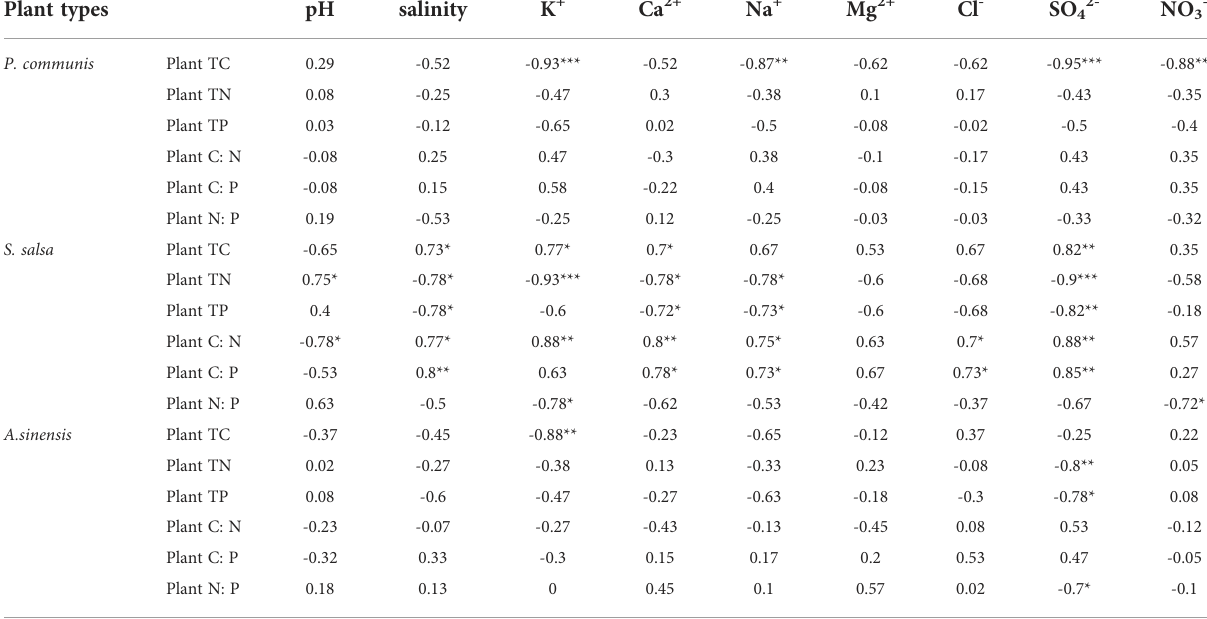
TABLE 2 Correlation between organ ecological stoichiometry and soil salt ions in three halophytes. Plant